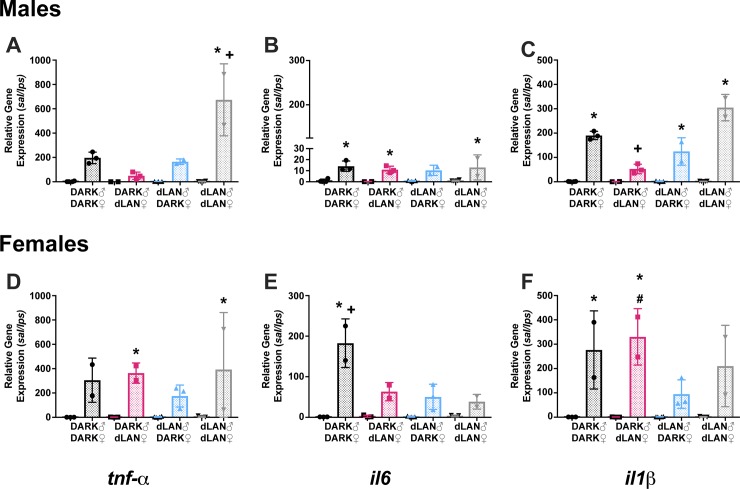
Paternal dLAN blunted hypothalamic cytokine gene expression in female offspring.Hypothalamic tnf-α, il-1, and il-6 expression 3 hours post-LPS challenge in males (A-C) and females (D-F). Open bars represent saline, dotter bars represent LPS. N = 2-4/group/sex; error bars represent SD. +, P < 0.05 vs all LPS; #, P < 0.05 vs dLAN-Dark LPS; *, P < 0.05 saline vs LPS.